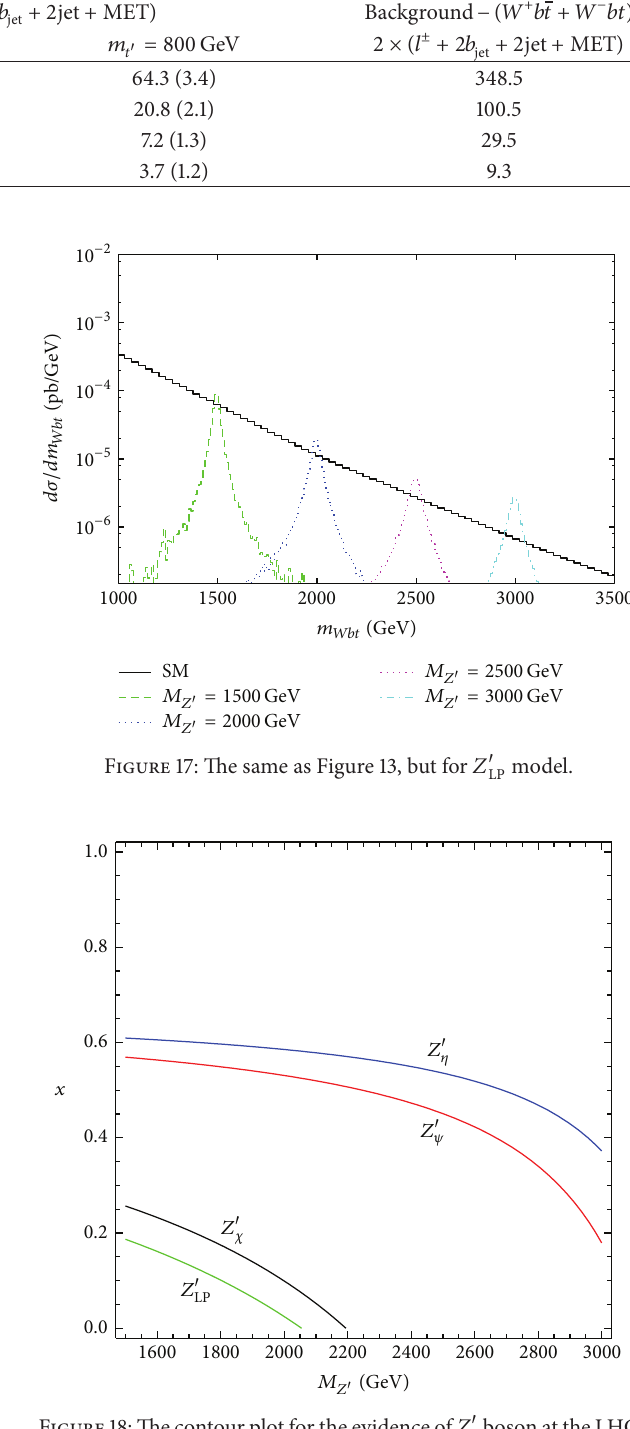
Figure 18: The contour plot for the evidence of 𝑍 󸀠 boson at the LHC ( √ 𝑠 = 13 TeV) with 𝐿 int = 100 fb −1 . The parameters used in the analysis are explained in the